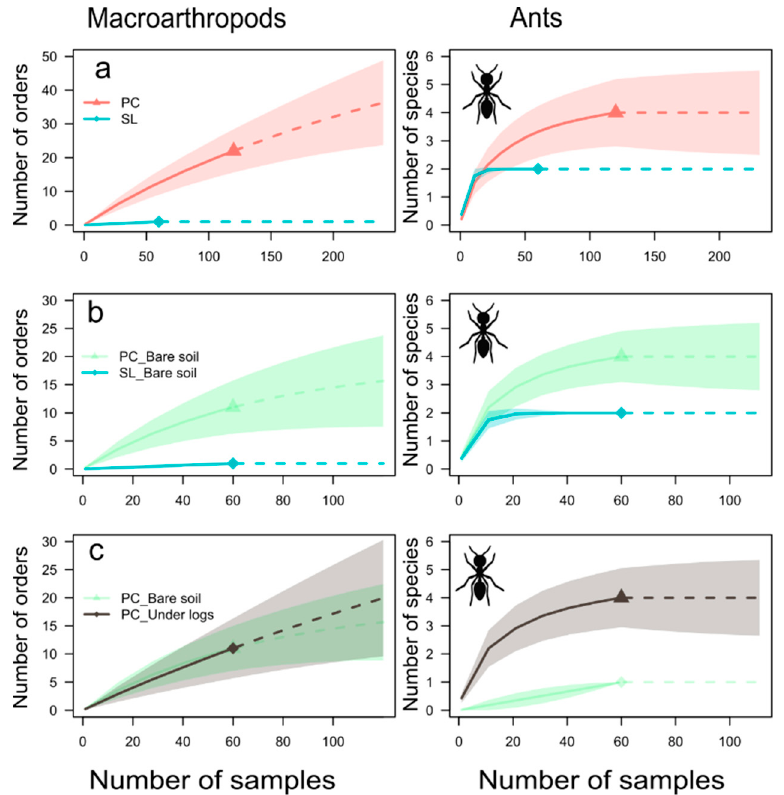
Figure A1. Sample-based rarefaction (solid lines) and extrapolation (dotted lines until reaching twice the maximum sample size) of macroarthropod orders and ant species at the High Plot. Shaded areas represent 95% confidence intervals. Panels show the three hypotheses of this study: differences between ( a ) dead-wood treatments, ( b ) treatments under the bare-soil microhabitat only, and ( c ) microhabitats in the PC treatment. Dead-wood treatments are SL = Salvage logging and PC = Partial Cut.